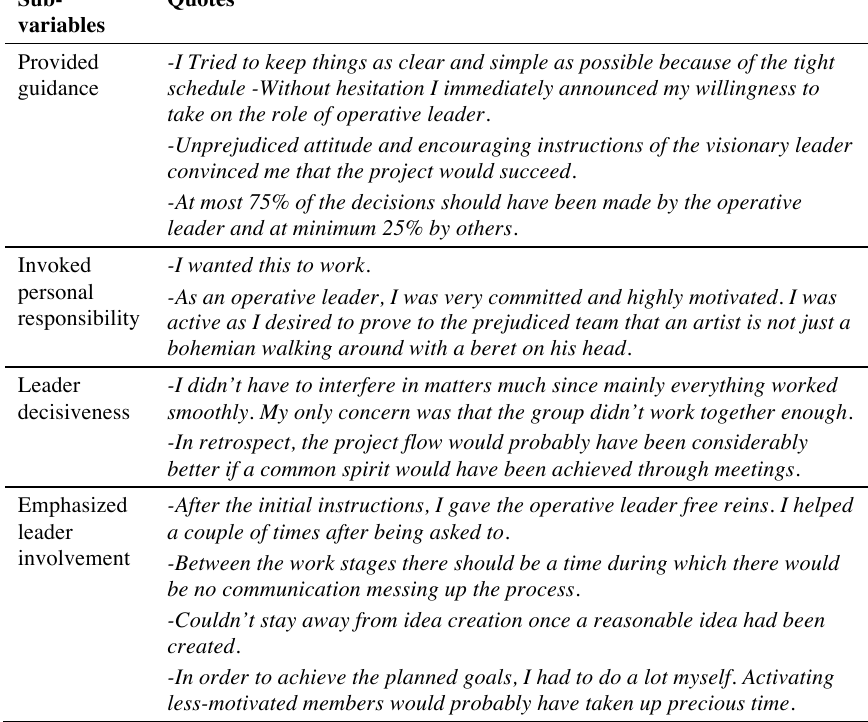
Table 2. Quotes related to visionary